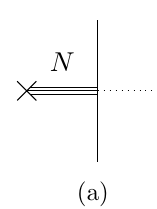
Figure 38. Supersymmetric Con(cid:12)guration. (a) Shows a system with N D3-branes. A phase transition takes it to the system (b), with ~ N = (cid:0) N D3-branes. The only possibility for both numbers to be positive is N = ~ N =